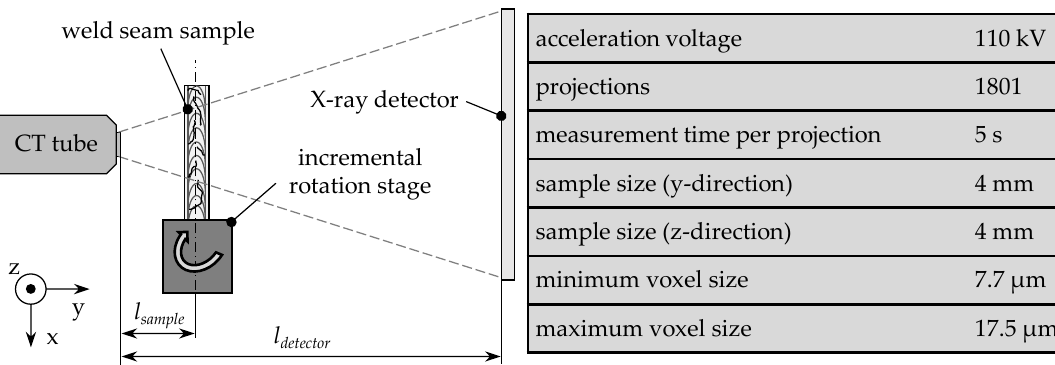
Figure 2. Schematic representation of the measurement set-up and measurement parameters for the acquisition of µ CT images of weld seam samples.